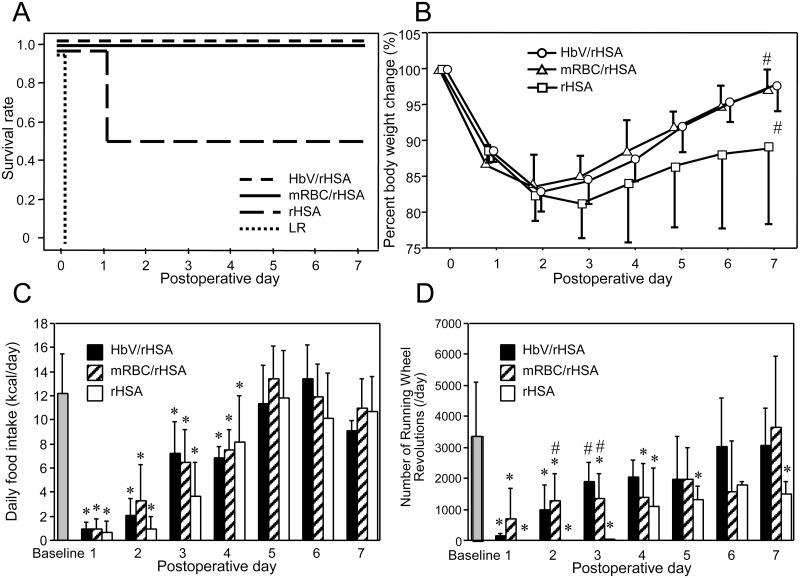
Differences in (A) survival rate, n = 10, (B) percent change in body weight (n = 10 initially in each group, n = 5 after the 1st postoperative day in the rHSA group), (C) daily food intake (n = 10 initially each group, n = 5 after the 1st postoperative day in the rHSA group), and (D) daily number of running wheel revolutions (n = 5 between the baseline period and the 7th postoperative day [POD] in the indicated study groups).Values are shown as the mean ± SD. *P < 0.05 versus baseline (Student’s t-test), #P < 0.05 versus the rHSA group (Dunnett’s test).